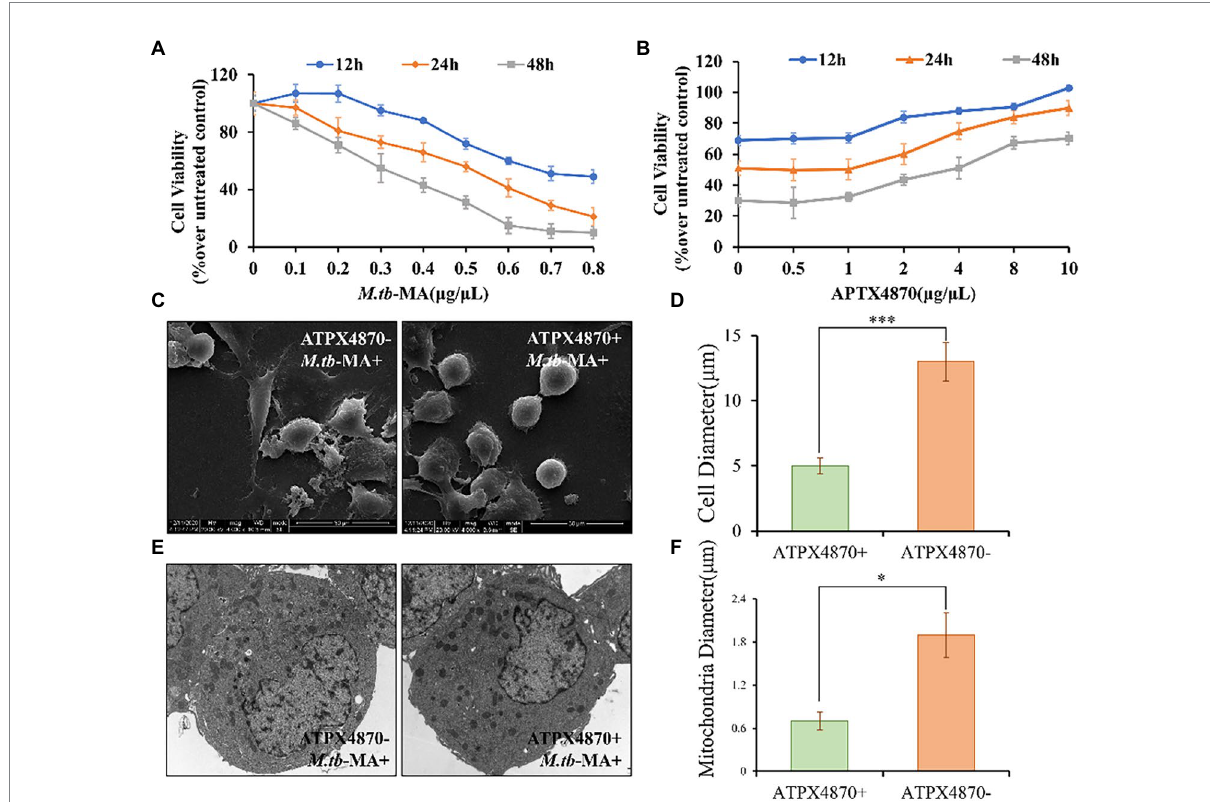
FIGURE 4 APTX4870 attenuates the decrease in viability and guards mitochondrial integrity induced by M.tb -MA. (A) The changes of THP-1 cell viability after being infected with M.tb -MA at a concentration of 0-1 μ g/ μ L for 12 h, 24 h, 48 h. Data were presented as mean ± SD ( n = 6). (B) The effects of APTX4870 were co-treated with 0.5 μ g/ μ L M.tb -MA for 12 h, 24 h, and 48 h. Data were presented as mean ± SD ( n = 6). (C) Scanning electron micrographs of THP-1 cells (SEM). (D) THP-1 cells diameter measurements in different groups ( n = 6). Data were presented as mean ± SD. *** p < 0.001: M.tb -MA vs. APTX4870 co-treated group. (E) Analysis of cell morphology by transmission electron microscopy (TEM). (F) Mitochondrial diameter measurements in different groups ( n = 6). Data were presented as mean ± SD. * p < 0.05: M.tb -MA vs. APTX4870 co- treated